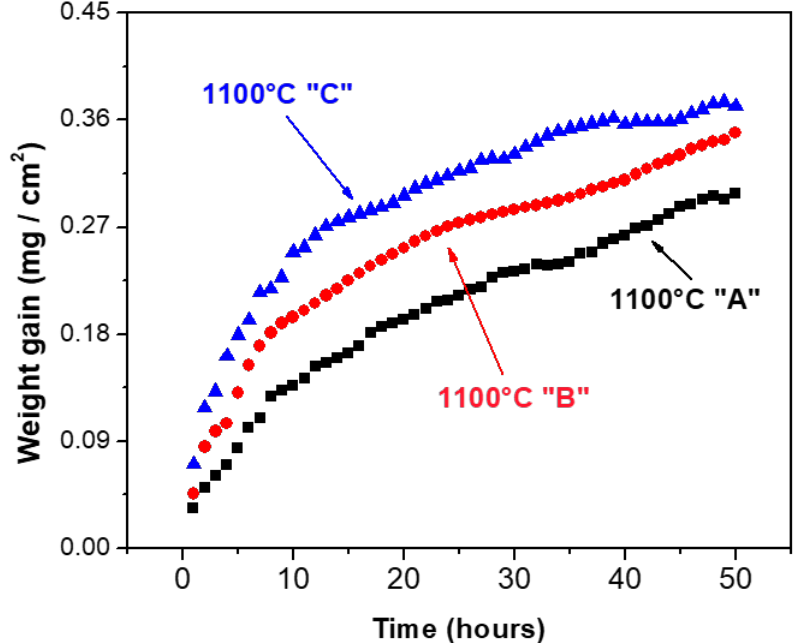
Figure 6. Results samples studied at 0 h (“A”), 8 h (“B”), and 20 h (“C”) of milling.